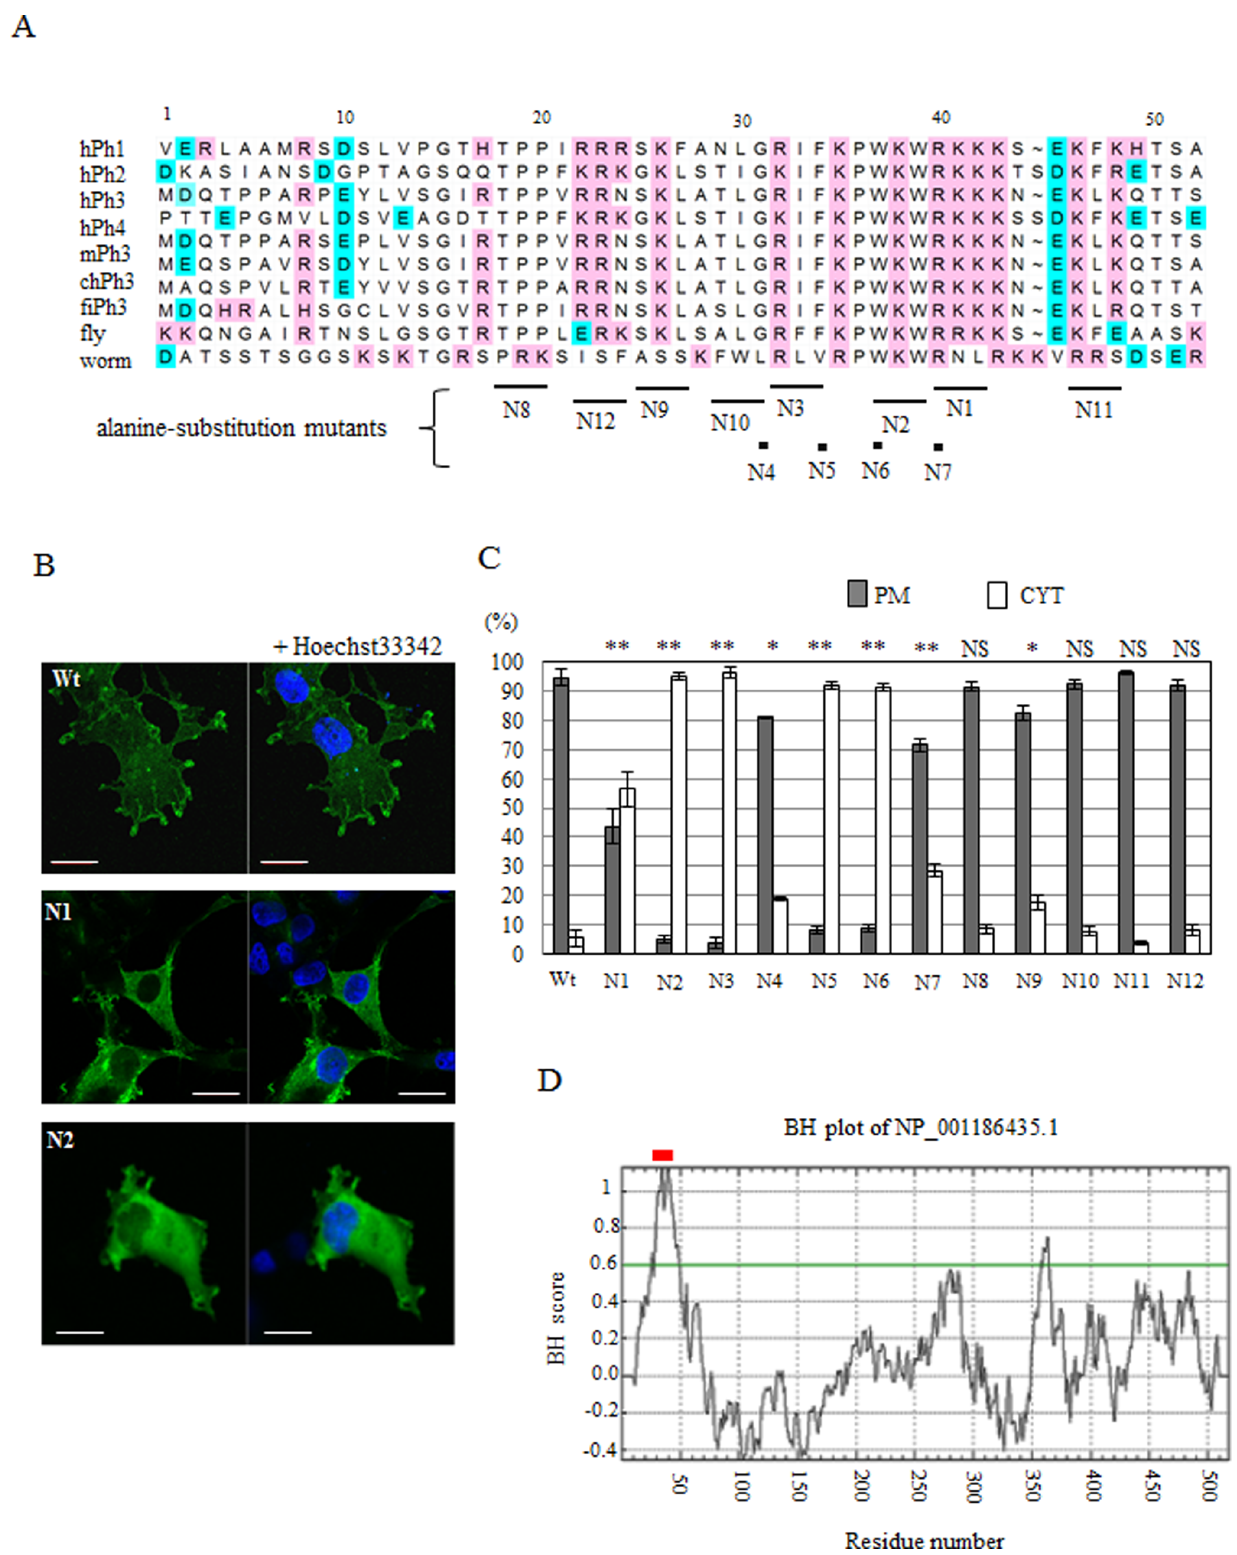
Figure 3. Basic and hydrophobic residues in the Nt are responsible for the distribution in the plasma membrane. (A) Alignment of the Nt amino acid (aa) sequences of phactr. Human phactr 1–4 (hPh1–4), mouse phactr3 (mouse), chicken phactr3 (bird), zebra fish phactr3 (fish), Drosophila melanogaster phactr (fly), and Caenorhabditis elegans phactr (worm) were aligned. N1–12 indicate substituted with alanine residues. (B) The distribution patterns of GFP-phactr3 Wt, N1, and N2. Cos7 cells expressing each construct were photographed using confocal laser microscopy at